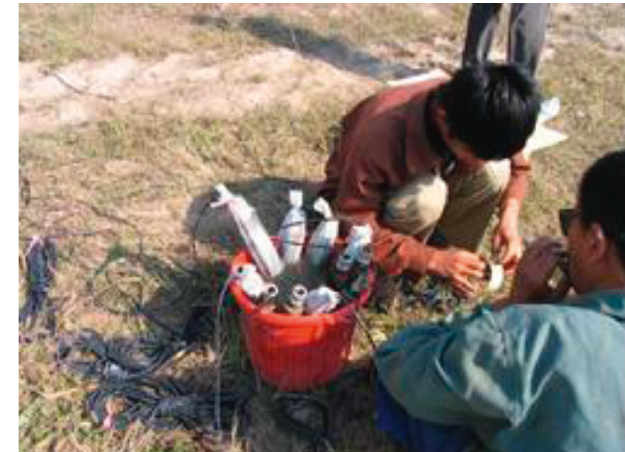
Figure 10: Embedment of piezometers.